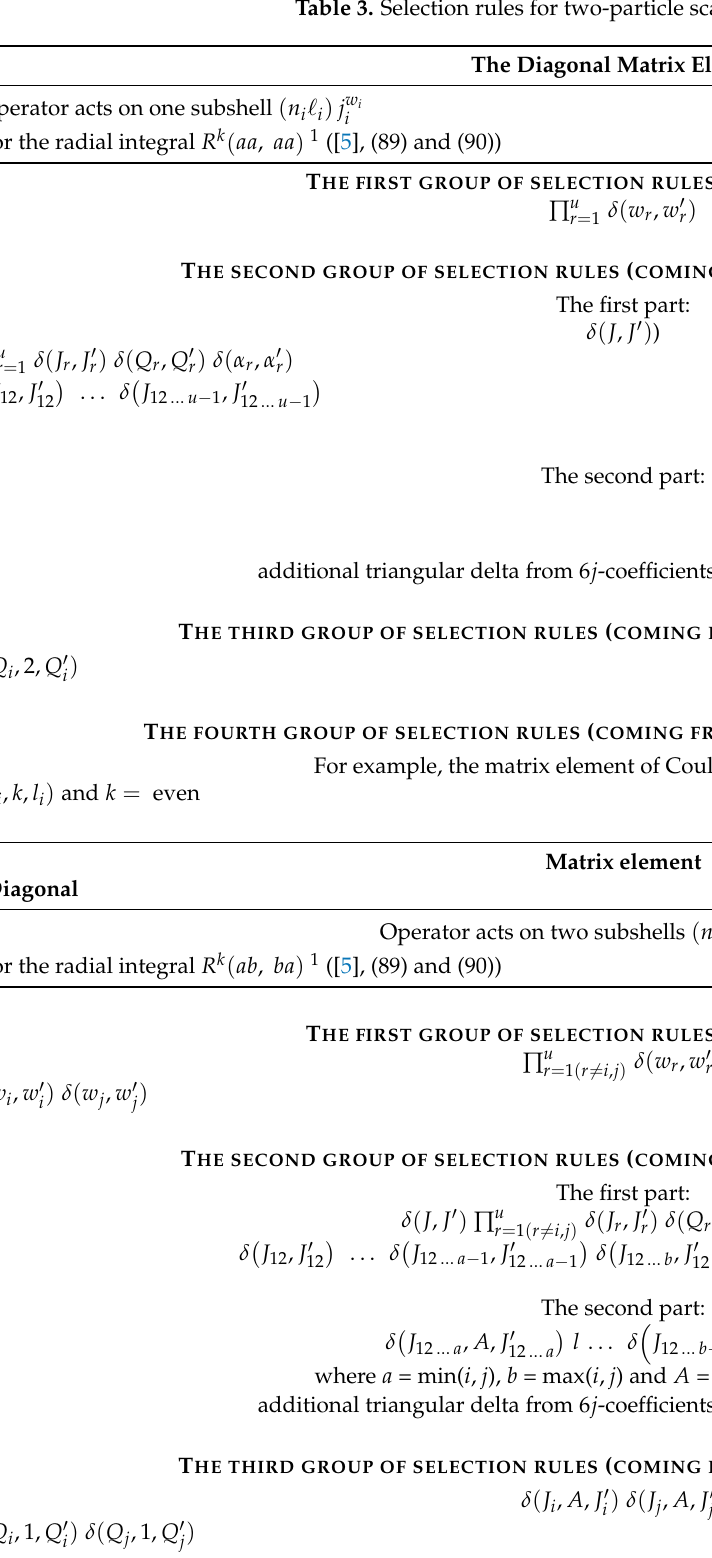
Table 3. Selection rules for two-particle scalar operator H